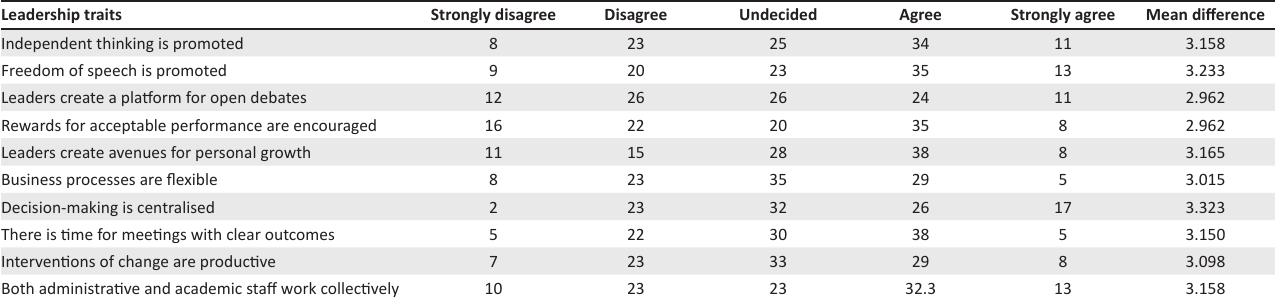
TABLE 1: Leadership traits’ effects on transformation. Leadership traits